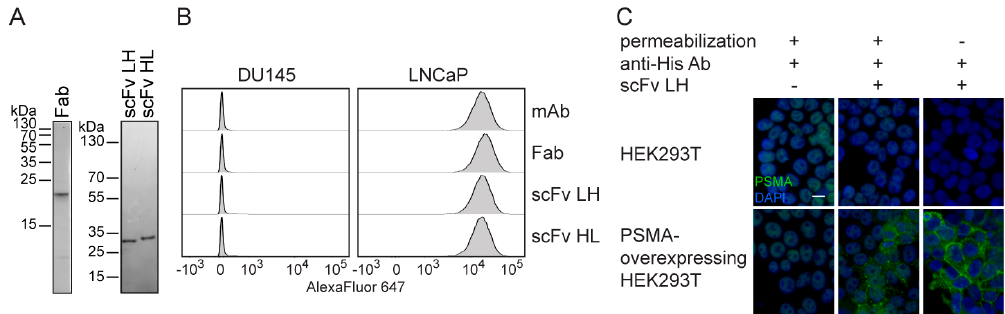
Figure 2. Characterization of 5D3 antibody fragments expressed in E. coli . ( A ) Purity of recombinant proteins was estimated from SDS-PAGE gel stained by Coomassie Brilliant Blue G-250 (CBB). ( B ) Binding of 5D3 variants on live cells was estimated by flow cytometry using anti-6×His antibody together with an anti-mouse IgG-Alexa Fluor 647 conjugate. All molecules used at saturating concentrations showed specific staining of PSMA-positive LNCaP cells with similar signal intensity. PSMA-negative DU145 cells were used as a control. ( C ) Indirect immunofluorescence microscopy using 5D3 scFv LH. PSMA-overexpressing HEK293T cells and the parent HEK293T cell line (a negative control) were fixed with/without permeabilization by Triton X-100 and incubated with 5D3 scFv LH. The fragment was then detected by anti-6×His Ab combined with anti-mouse Alexa Fluor 488 conjugate (green channel). Cell nuclei were counterstained by DAPI (blue channel). The scale bar represents 25 µm.